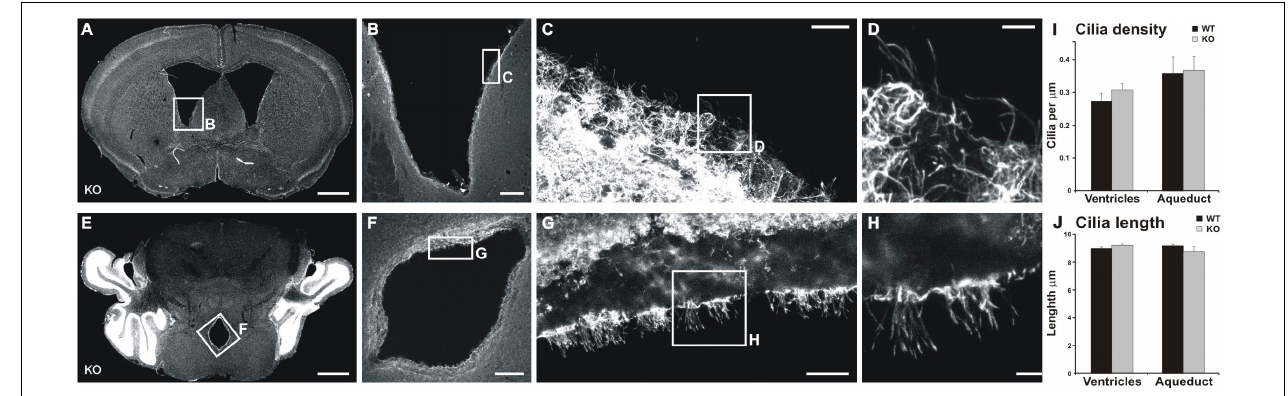
FIGURE 7 | Cilia are not altered in the ventricle or aqueduct walls of MIM KO mice. (A,D) Representative coronal section of the lateral ventricle (A) and cerebral aqueduct (D) . (B–D,F–H) show an enlarged selected area of the lateral ventricle or cerebral aqueduct wall with acetylated tubulin staining used to measure cilia density and length. (I) Cilia density was calculated for each image as the number of cilia divided by the length of the ventricle edge. (J) To assess the length of cilia we measured the length of visible cilia with the “segmented line” tool in ImageJ. Scale bars: (A,E) 1000 µ m, (B,F) 200 µ m, (C,G) 20 µ m, (D,H) 5 µ